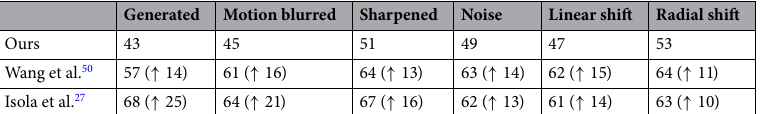
Table 1. Comparisons between Fréchet inception distance (FID) Achieved by Our Method Compared with Wang et al. and Isola et al.